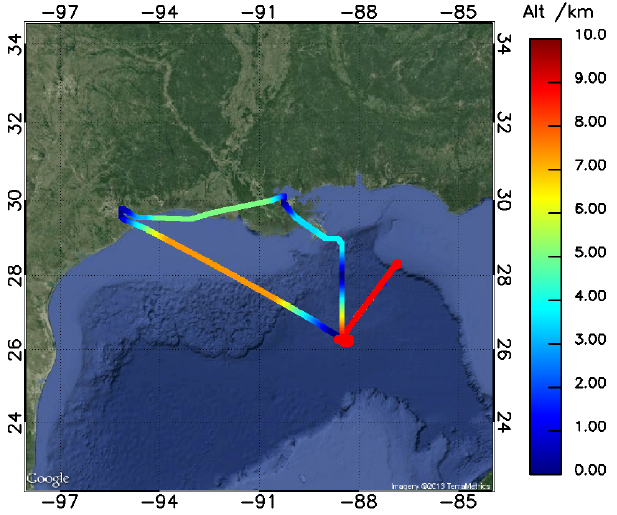
Figure 1. Flight track of FAAM flight B290 on 30 April 2007 over the Gulf of Mexico, colour coded for altitude as indicated in the legend. Permission granted by Google Maps and TerraMetrics, Inc to display the imagery shown here.